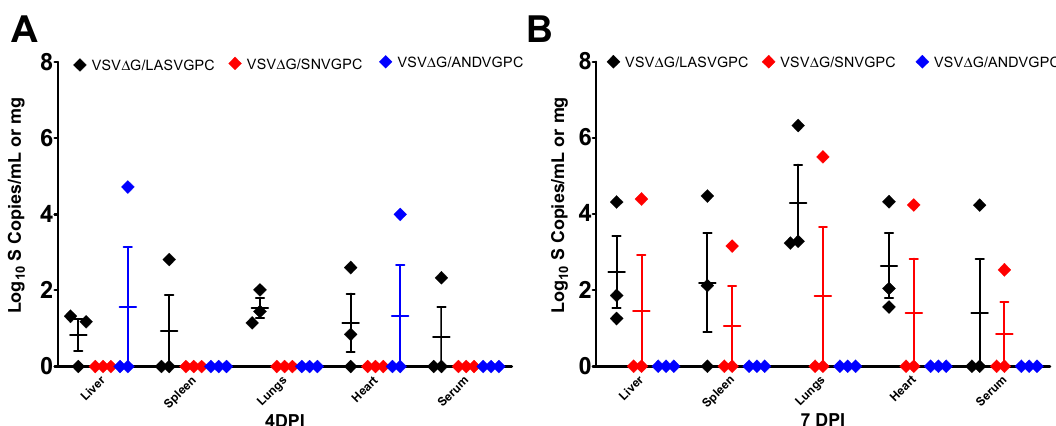
log-rank test ( A ). **, p = < 0.01.